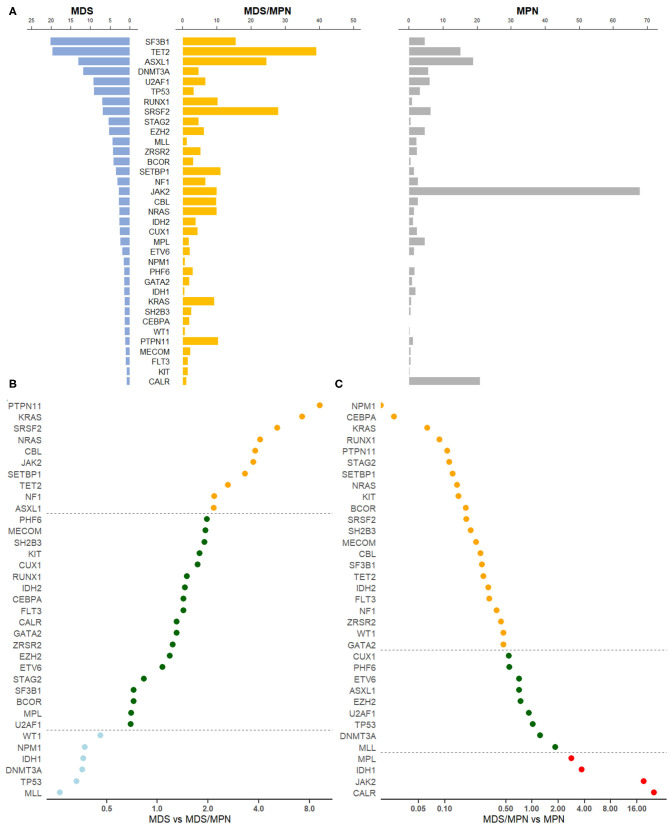
Gene mutation profiles for MDS, MDS/MPN, and MPN. (A) Pooled frequencies (%) of major mutations in all three myeloid tumors were plotted. The mutation frequency was obtained by meta-analysis. If heterogeneity was considered to be significant, i.e., I2 ≥ 50%, a random-effects proportion was used, otherwise a fixed-effects model was adopted to combine the frequencies. Bars in light blue represented mutation frequencies in MDS, orange for MDS/MPN and gray for MPN. (B) Odds ratio of meta-mutation-frequency between MDS and MDS/MPN were presented in scatter plots. X-axis was presented in the scale of log2. Dots in light blue stood for genes whose odds ratios were <0.5, suggesting higher risk toward MDS, whereas orange dots were representing genes whose odds ratios were more than 2.0, suggesting higher risk toward MDS/MPN. If the odds ratio was in the middle of 0.5 and 2.0, the correspondent gene would be green. The line of ratios, 0.5 and 2.0, were shown horizontally. (C) Odds ratio of meta-mutation-frequency between MDS/MPN and MPN are presented in scatter plots. X-axis was presented in the scale of log2. Dots in orange stood for genes whose odds ratios were <0.5, suggesting higher risk toward MDS/MPN, whereas red dots were representing genes whose odds ratios were more than 2.0, suggesting higher risk toward MPN. If the odds ratio was in the middle of 0.5 and 2.0, the correspondent gene would be green. The line of ratios, 0.5 and 2.0, were shown horizontally.